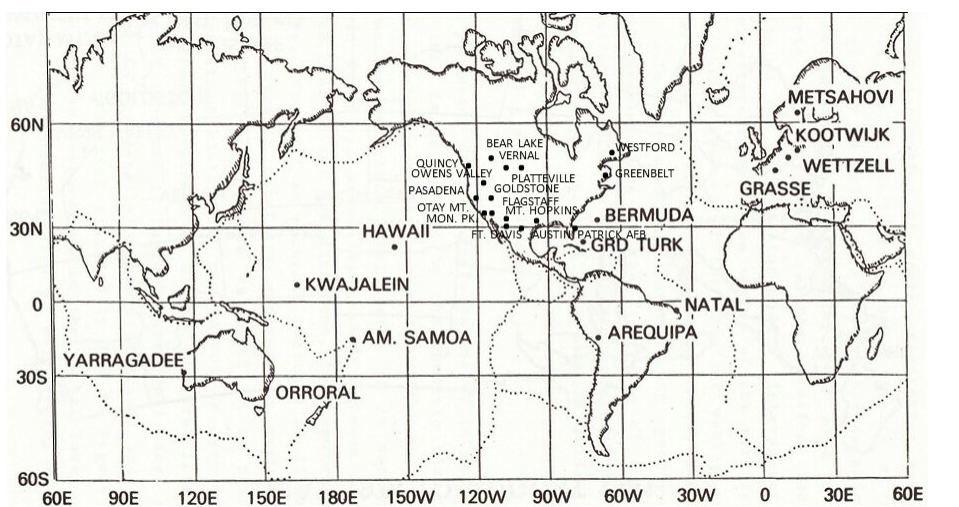
Figure 5. Satellite laser ranging network in the early 1980s (Christodoulidis et al.,